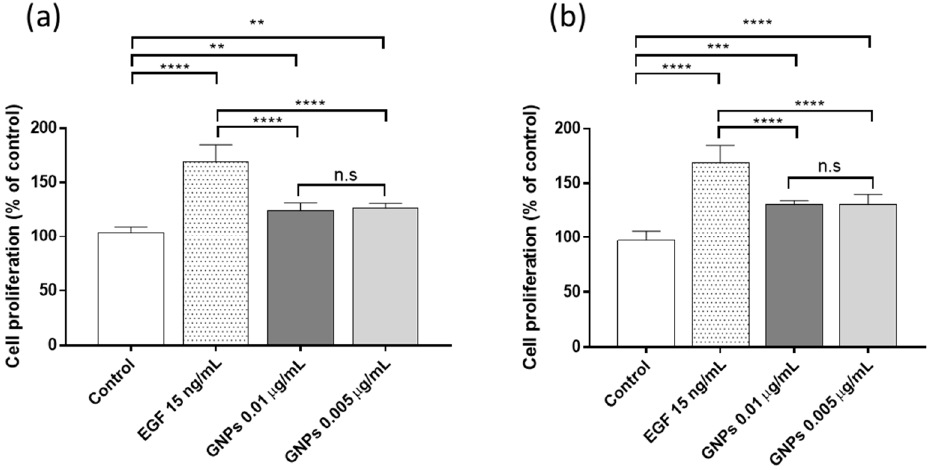
Figure 5. Proliferative activity of GNPs in human keratinocyte HaCaT cells treated with graphene nanoplatelets (GNPs) at non-cytotoxic concentrations (0.005 and 0.01 µg/mL) for 72 ( a ) or 96 ( b ) h. Data are expressed as the mean ± standard deviation of six replicates. The results of the statistical analysis with respect to control and to the epidermal growth factor (EGF) are indicated in the graph: ** p < 0.01; *** p < 0.001; **** p < 0.0001; n.s: not significant.